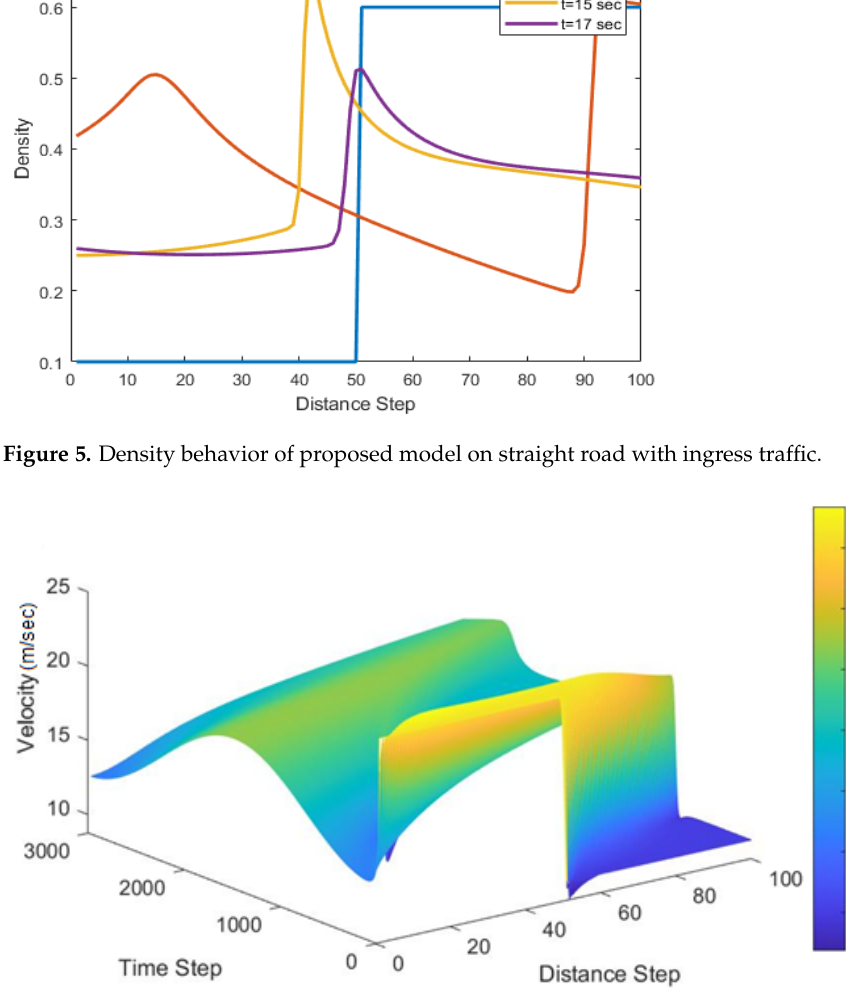
Figure 7. Velocity behavior of proposed model on straight road with ingress traffic. 5.2. Straight Road with No Ingress Traffic In this case, there is no incoming traffic, and the existing traffic, which has been in- troduced to the road section as an initial condition, is leaving the road segment at a very high velocity. The total simulation time, in this case, was reduced to just 2 s. This is be- cause, after a few seconds, all the traffic has left the road section and no vehicles are left on the road. A sudden vacuum is produced, resulting in negative densities, which is not possible. First, the PW model is simulated. The density behavior is shown in Figure 8, which is well within the defined range. However, a very interesting observation can be made here. Despite all the traffic leaving the road section and no vehicles entering it, the density is observed to increase at some distance steps with the passage of time, which is unrealistic. The velocity behavior of the PW model is shown in Figures 9 and 10. Again,